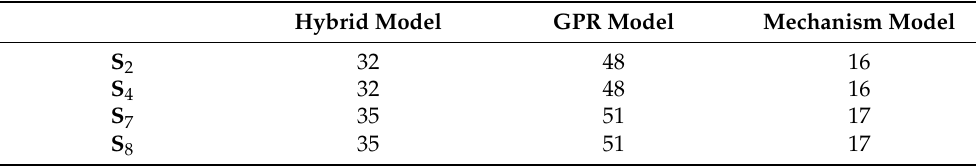
Table 4. The number of samples required for test sets of the hybrid, GPR, and mechanism